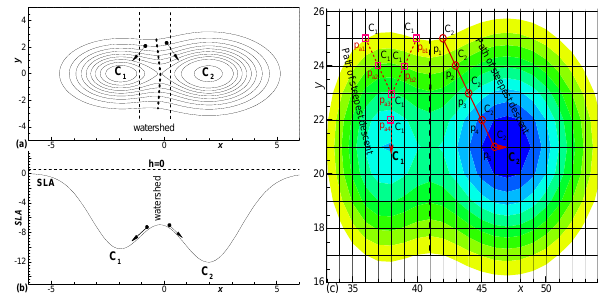
Figure 2. (a) The watershed as the natural division of eddies. (b) The particles on the watershed flow downward to the eddy cen- tres. (c) Sketch map of the fast descent algorithm, where the dashed line indicates the watershed. The squires with arrows are paths to eddy C 1 , while the circles with arrows are paths to eddy C 2